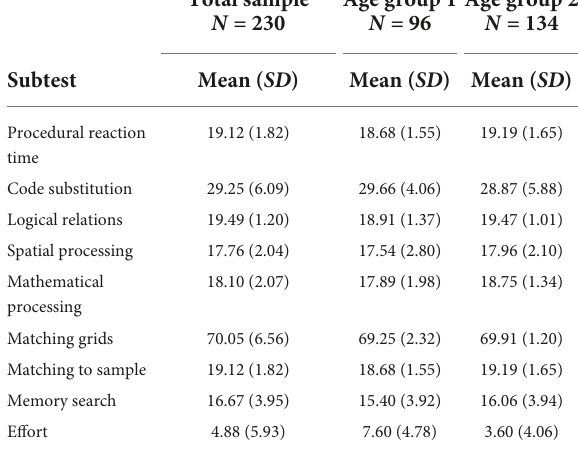
TABLE 5 Ped-ANAM hits by subtest.